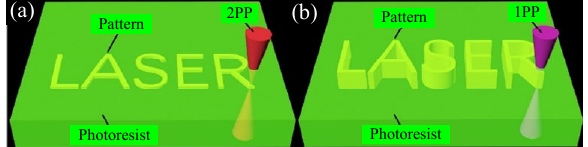
Fig. 1 Schematic diagram of 2PP: (a) two-photon direct write “LASER” pattern and (b) single-photon direct write “LASER”